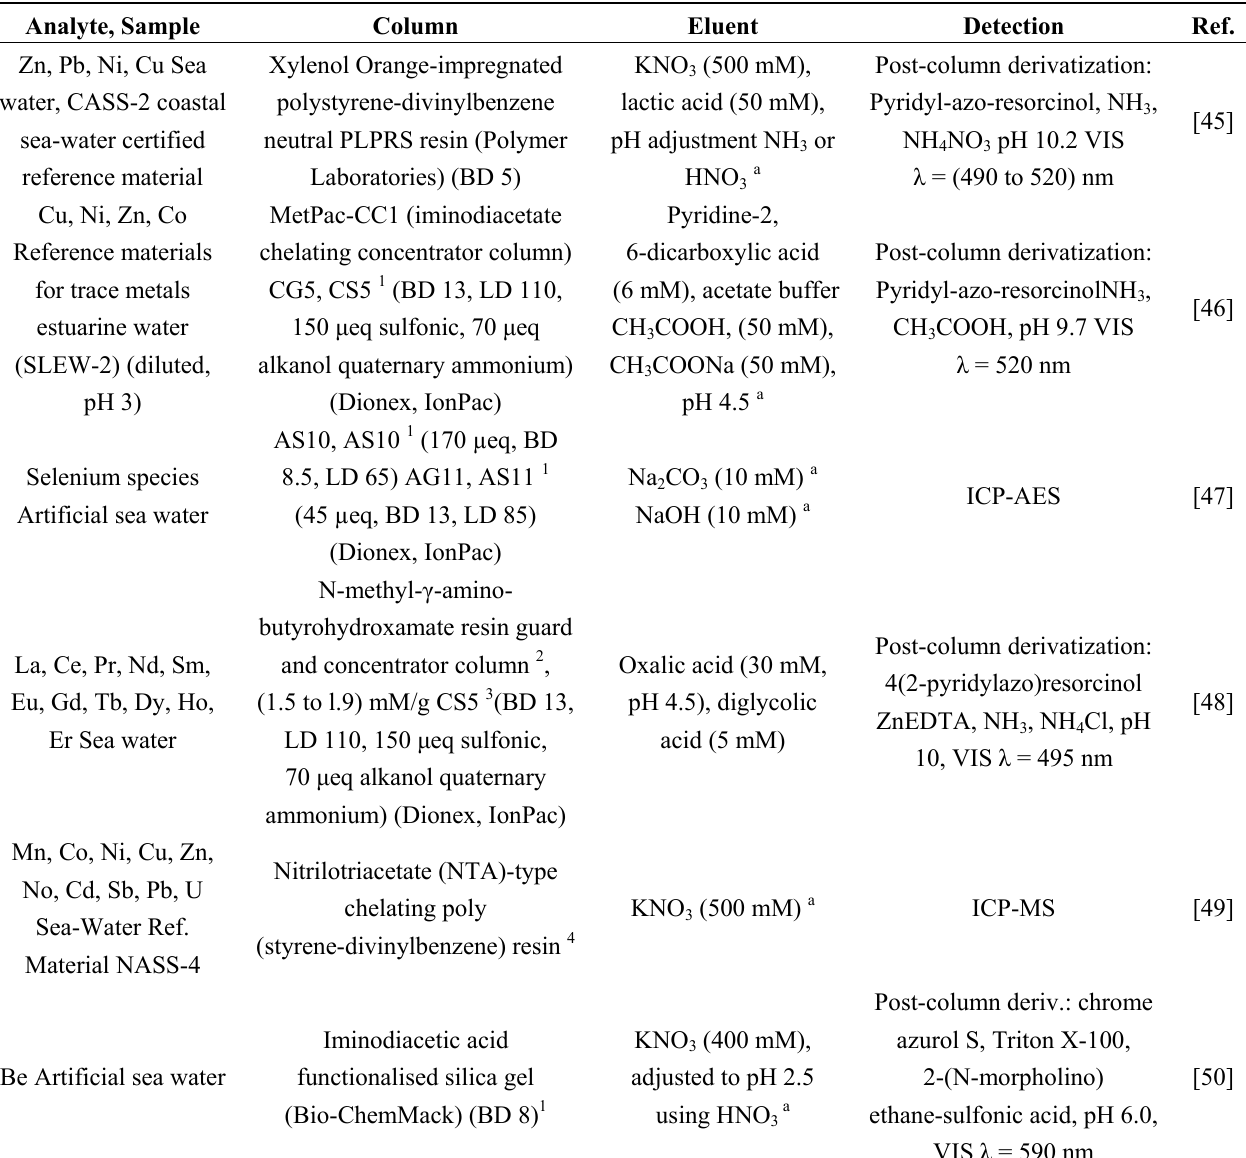
Table 5. Ion chromatographic determinations of concentrations of